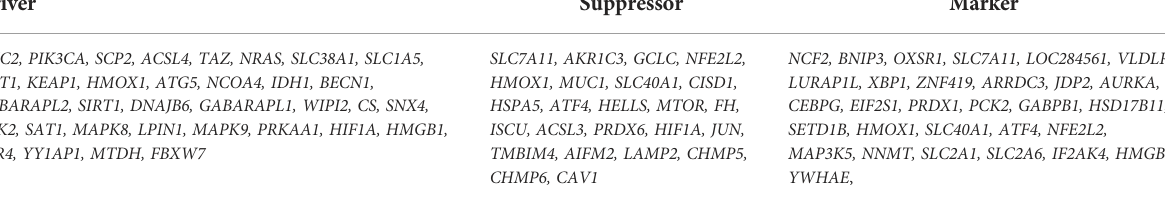
TABLE 1 Summary of the